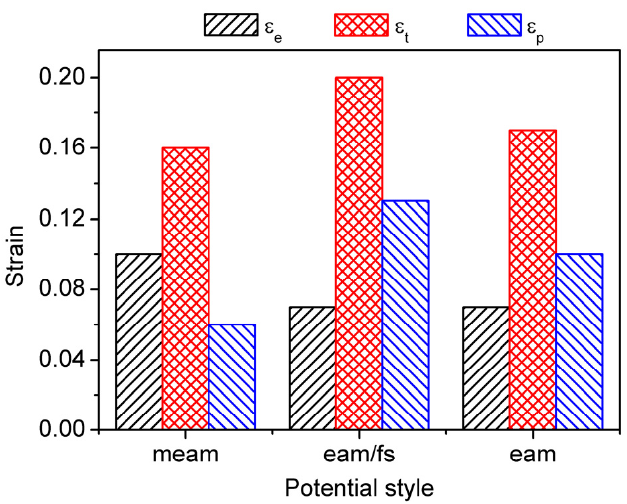
Figure 3. The elastic strain ε e , total strain ε t and accumulated plastic strain ε p of single-crystal Ni under different styles of interatomic potentials.